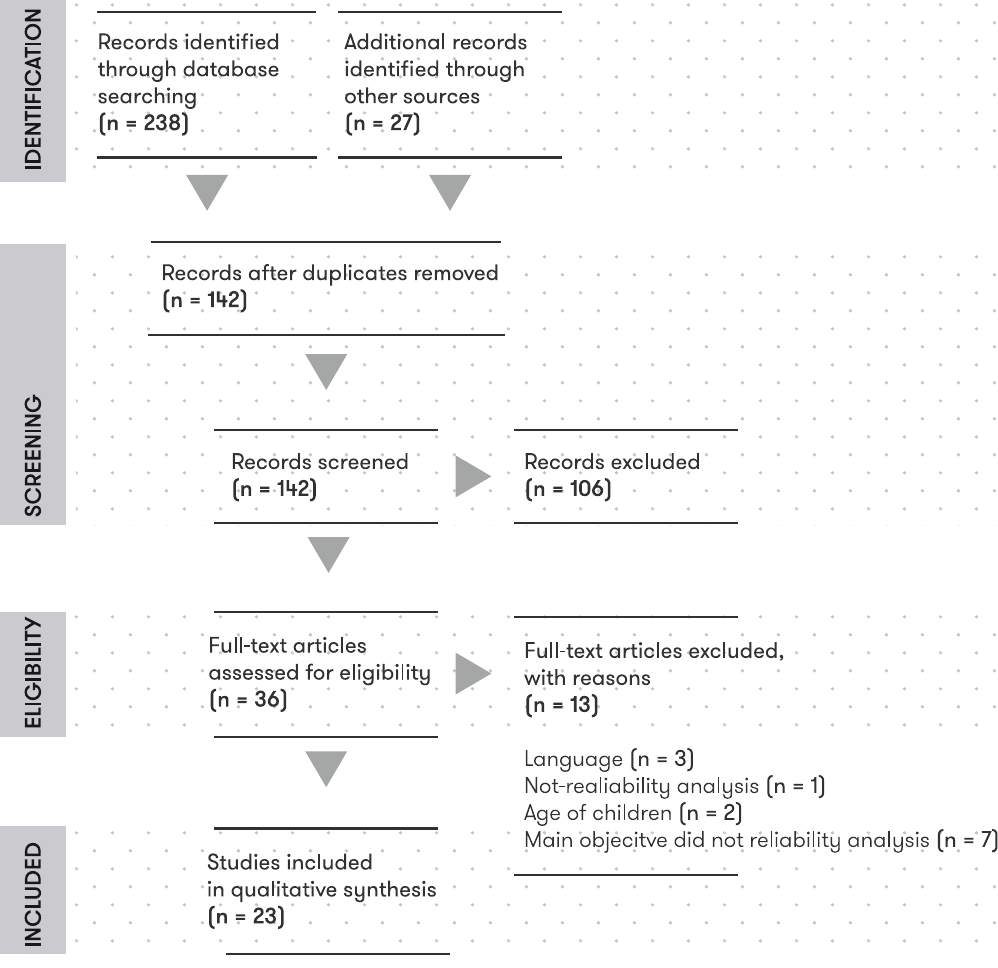
Fig 1. Flow diagram of the search and study selection